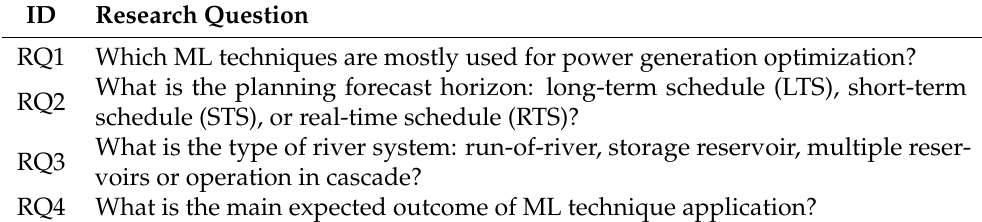
Table 1. Research